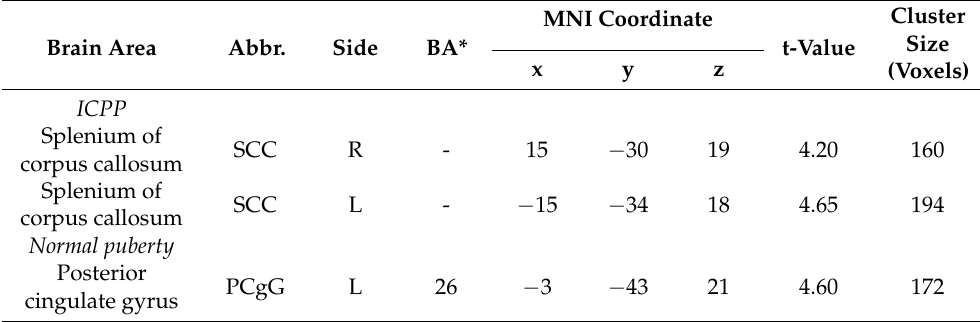
Table 3. Brain regions showing different white matter volumes between patients with ICPP and normal puberty controls (uncorrected; p < 0.001, excluded 100 voxels). MNI Coordinate Brain Area Abbr.